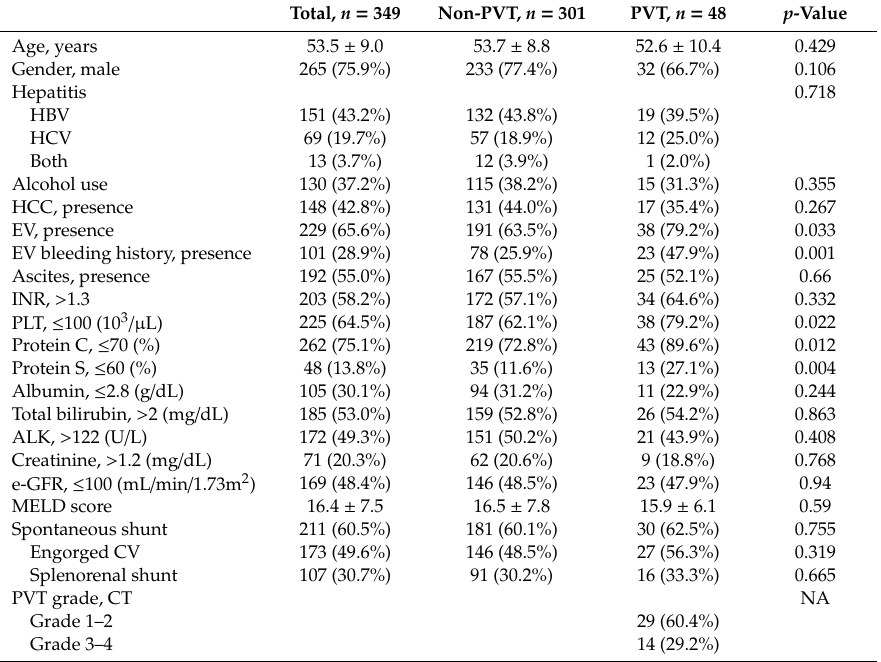
Table 1. Clinical characteristics of 349 cirrhotic patients with or without portal vein thrombus